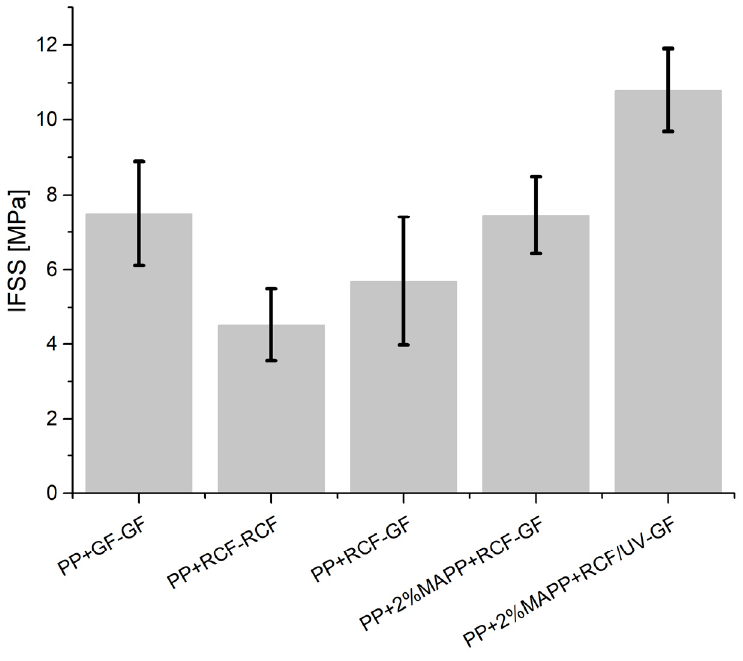
Figure 8. IFSS of hybrid amplified samples with reference values and different bonding.